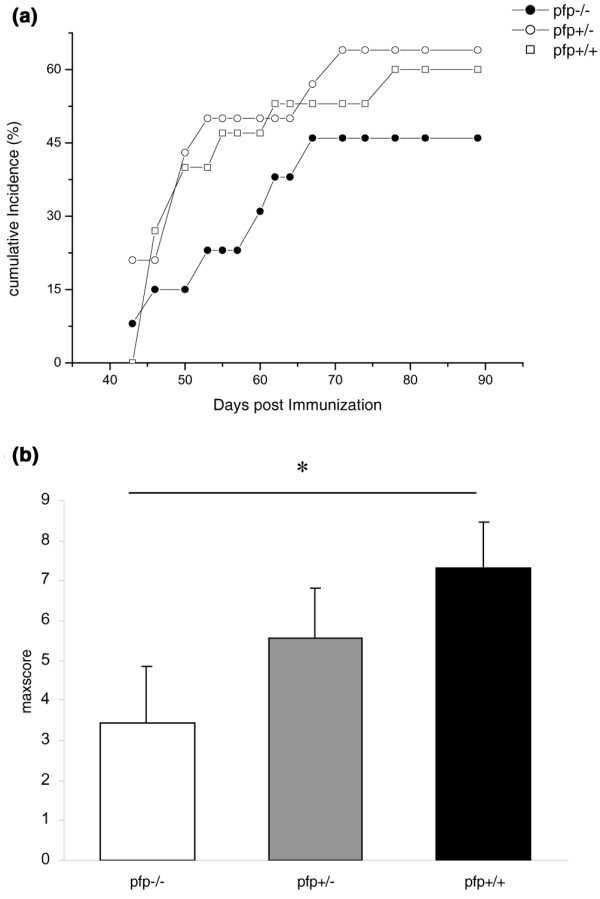
Perforin-deficient (pfp-/-) mice develop decreased collagen-induced arthritis (CIA). Percentage of CIA-affected animals (a) is decreased and average maximum score (b) is significantly lower in pfp-/- mice than in pfp+/- and pfp+/+ mice. Figures show results from two different experiments, with balanced groups, taken together. Maxscore was calculated as the mean maximum score for each individual mouse of a given genotype. *P < 0.05.